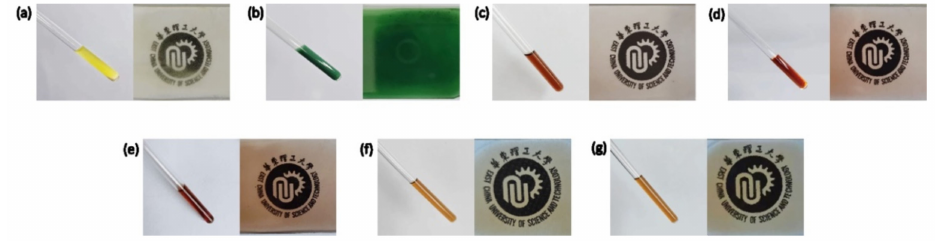
Figure 2. Solubility of ( a ) BPh; ( b ) BPh-B; ( c ) BPh-Q 5 ; ( d ) BPh-Q 10 ; ( e ) BPh-Q 15 ; ( f ) BPh-Q 20 ; ( g ) BPh-Q 30 in THF, the solid content is 20%. Apply the solution on the glass to compare the